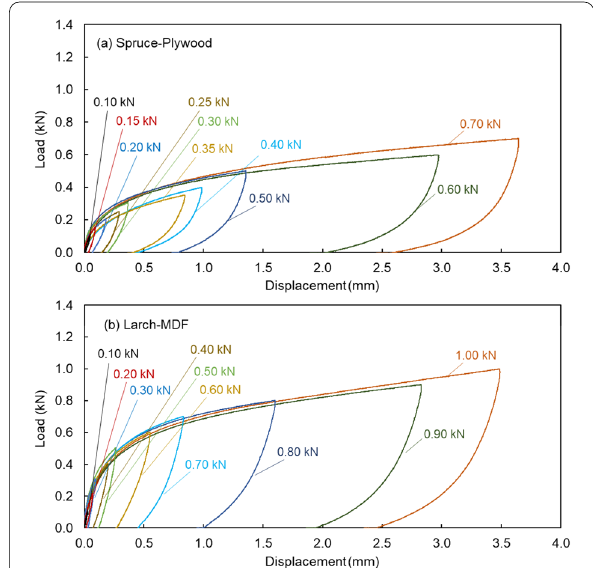
Fig. 6 Examples of load–displacement relationships obtained via the reversed loading test. The legends denote the target load per a